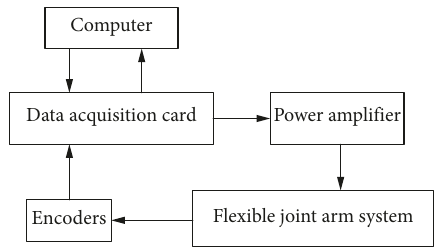
Figure 3: Diagram of the experimental platform